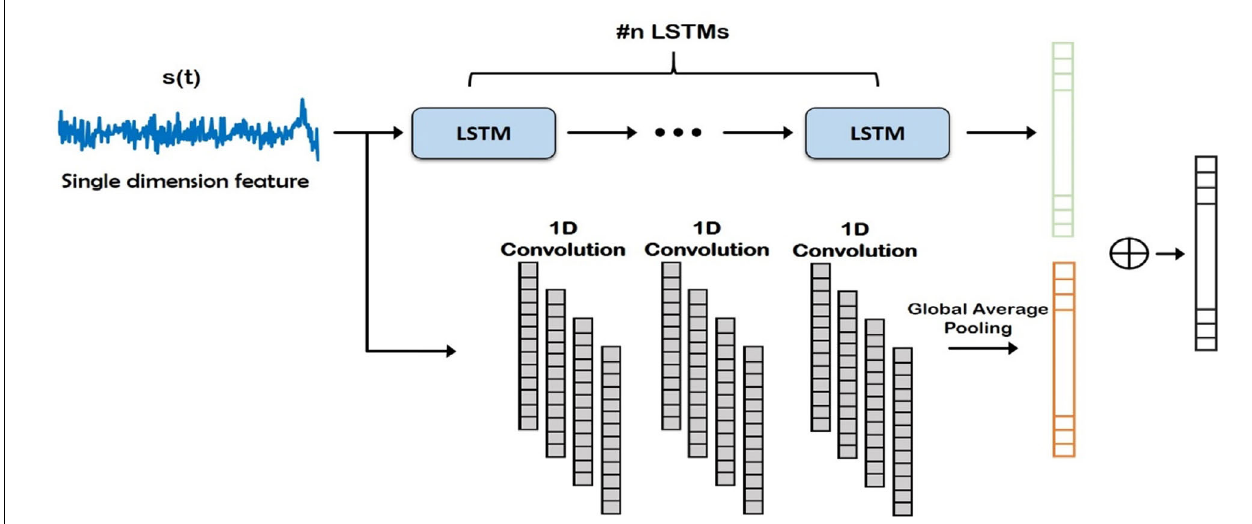
FIGURE 3 | Deep network structure for extraction of time domain features from the input signal. Note that these features are combined with frequency domain features (Auto-Regressive) later for final prediction of the channels. LSTM, Long Short Term